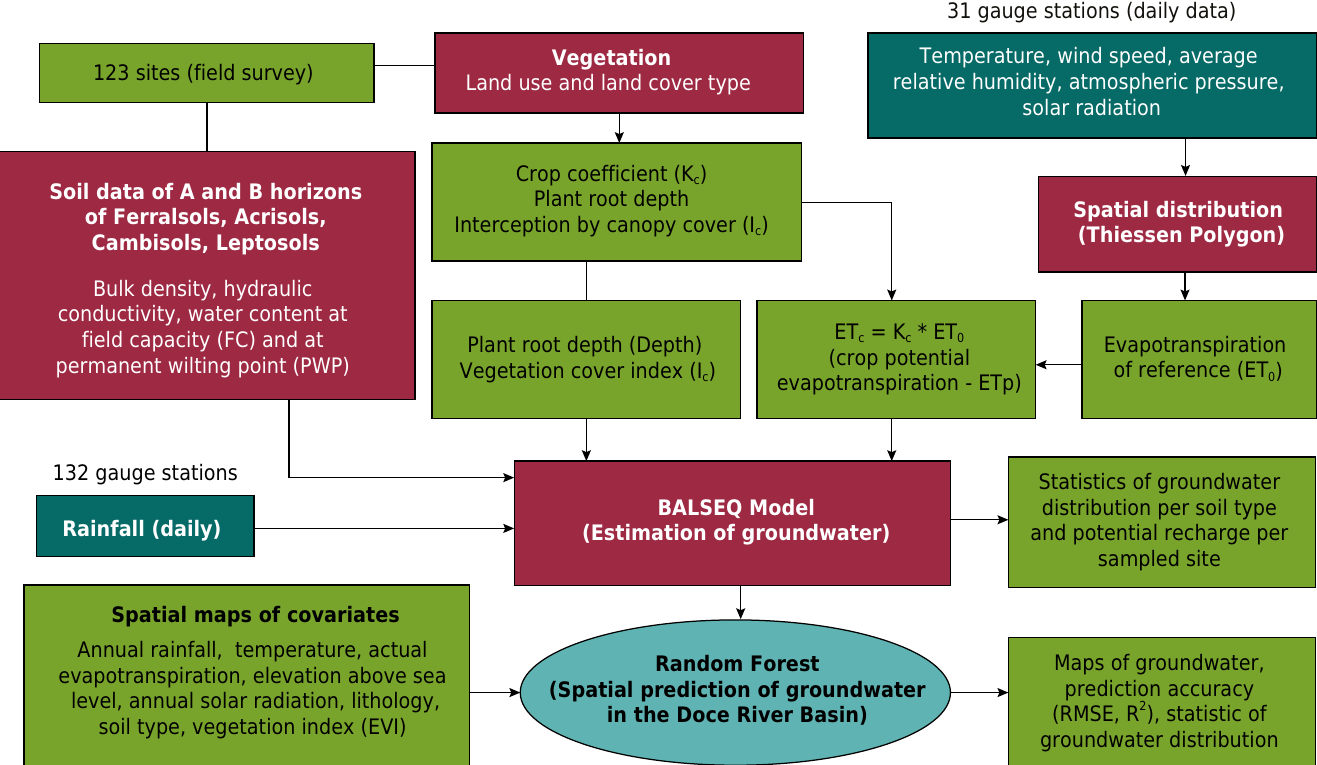
Figure 1. Flowchart of the methodological groundwater estimation and spatial prediction in the Doce River Basin, Minas Gerais,